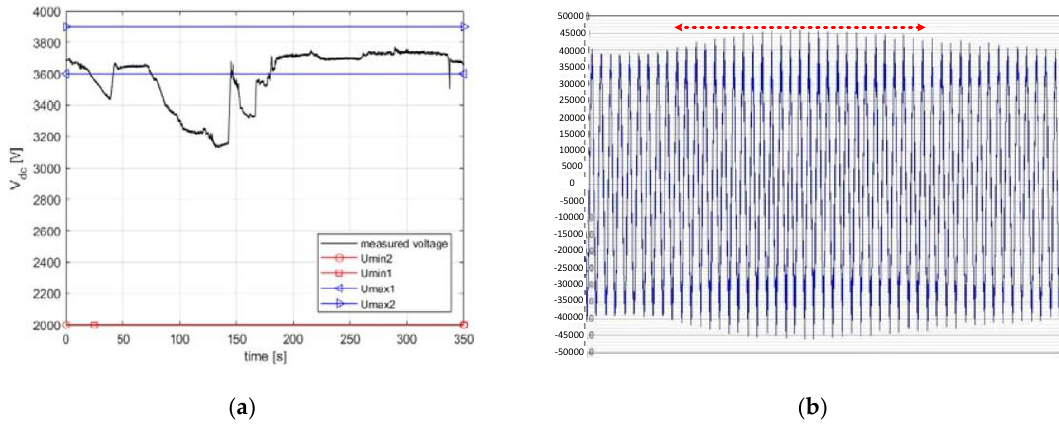
Figure 16. Measured voltage swell in ERPS. ( a ) 3 kV DC line in Italy [109]. ( b ) Korea HSR (G7) [108].